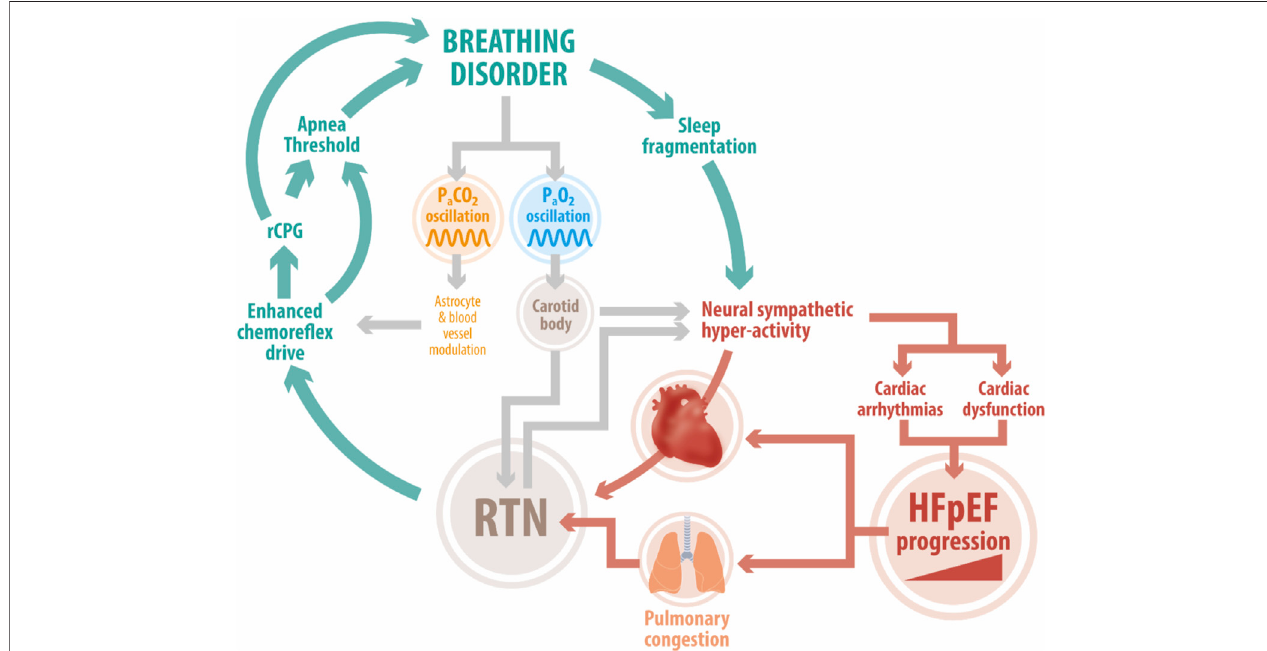
FIGURE 1 | Deleterious positive feedback loop in HFpEF. Enhanced chemore fl ex drive isa pathophysiological hallmark in HFpEF patients. Studies in experimental HFpEF show that acute activation of the central chemore fl ex exacerbates elevated cardiac sympathetic tone, disordered breathing, and cardiac dysfunction. The RTN, an important locus of central chemoreception, may play a role in development/maintenance of disordered breathing patterns (i.e., periodic breathing, sleep apnea). Acute fl uctuations in P a CO 2 affect RTN and carotid body chemoreceptor activity which together stimulate increases in sympathetic out fl ow and pulmonary ventilation. This in turn hastens the development of cardiac arrhythmias and cardiac dysfunction. In addition, breathing disorders can trigger sleep fragmentation which further exacerbates sympathoexcitation and stresses the failing heart. Abbreviation: HFpEF, heart failure with preserved ejection fraction; RTN, Retrotrapezoid nucleus; RPG, respiratory pattern generator; P a CO 2 , arterial pressure of CO 2 ; P a O 2 , arterial pressure of O 2 ; CBs, carotid bodies.